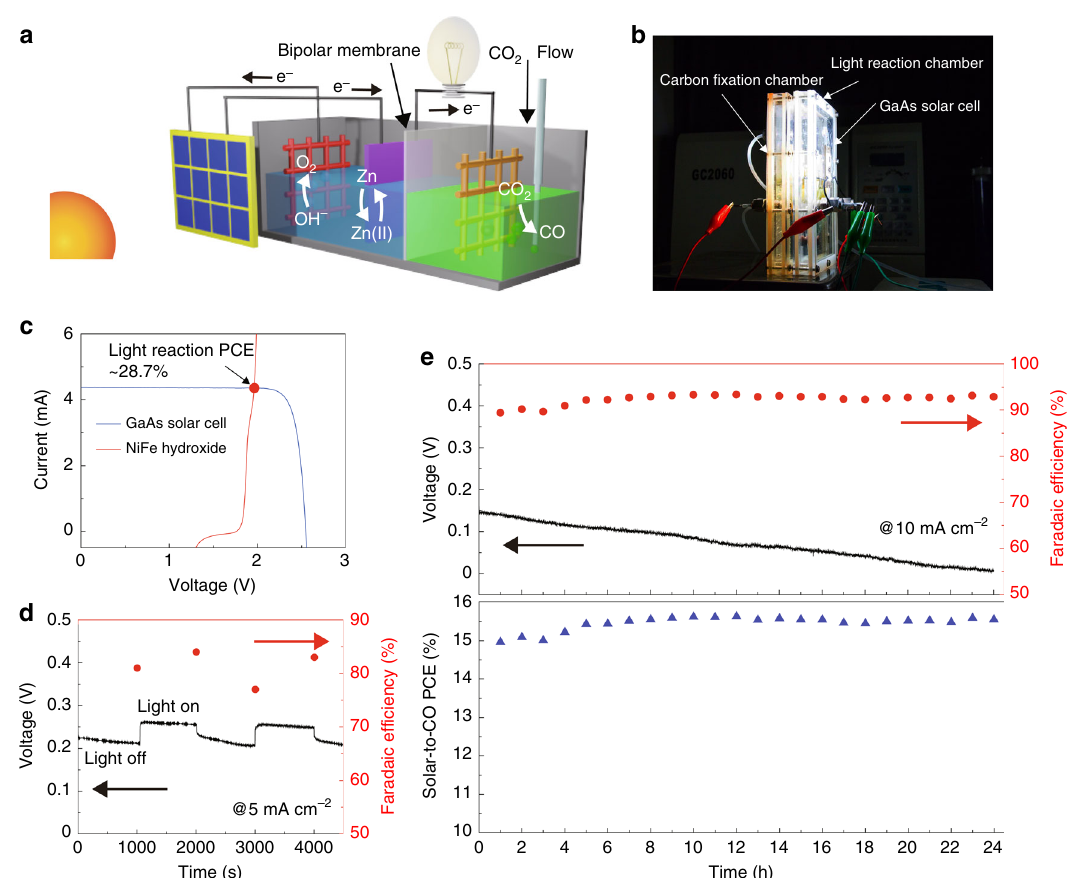
Fig. 4 The redox-medium assisted CO 2 electroreduction system. a Schematic and b photograph of the redox-medium-assisted system. c Photovoltaic and electrocatalytic current-voltage curves of the GaAs solar cell (blue curve) and two-electrode O 2 evolution (red curve). The red dot indicates the maximum power conversion ef fi ciency (PCE) point of the designed arti fi cial light reaction, based on photoelectrochemical O 2 evolution and Zn deposition. d Voltage- versus-time and FE CO pro fi les of the overall photosynthesis under chopped simulated AM 1.5 G illumination. The current density for CO 2 reduction was 5 mA ∙ cm − 2 . e The voltage-versus-time pro fi le, FE CO , and solar-to-CO PCE of the redox-medium-assisted system at a current density of 10 mA ∙ cm −